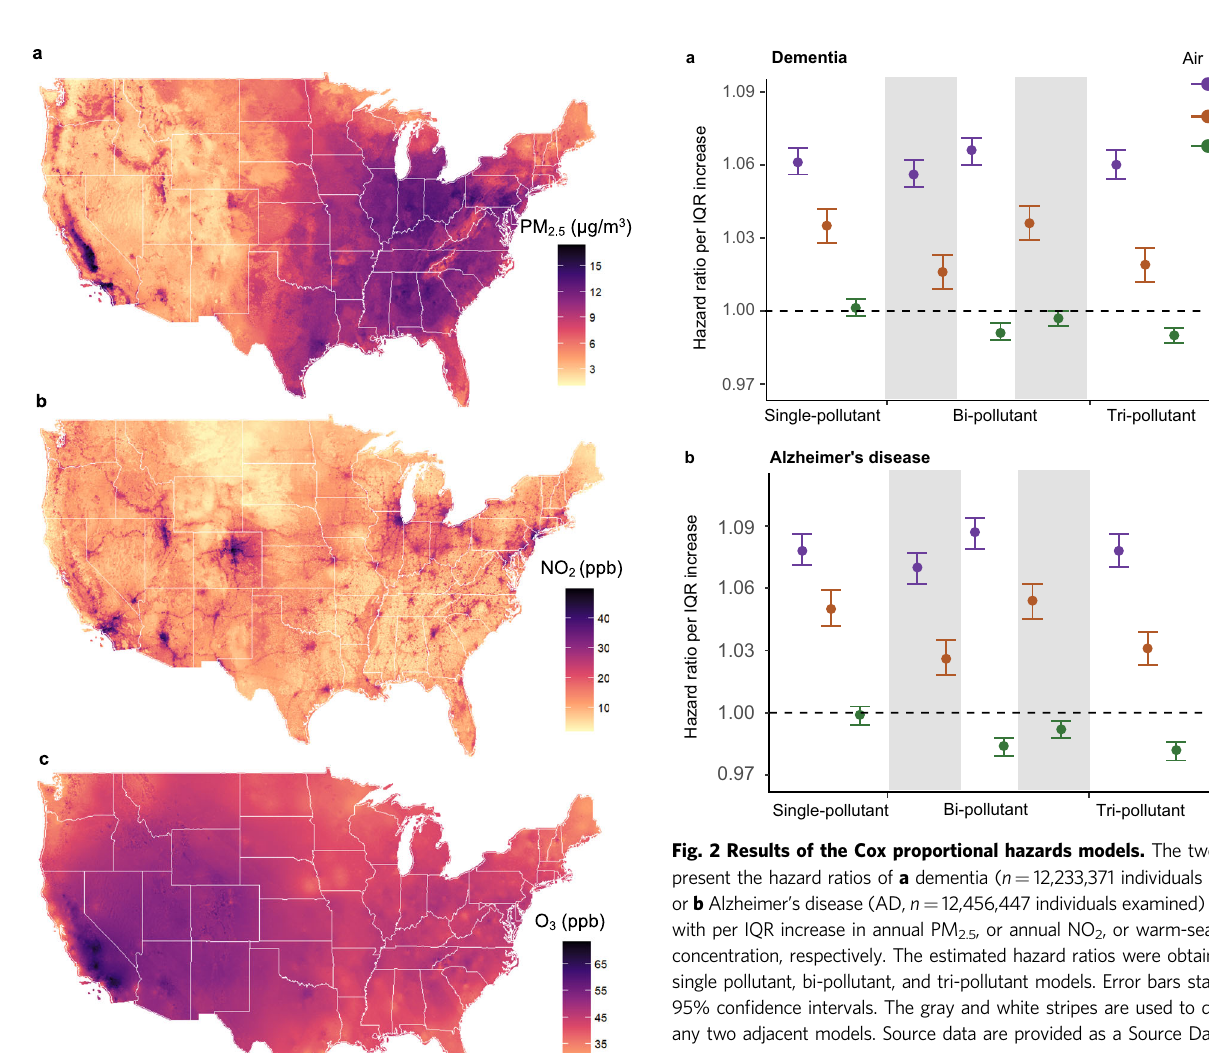
The fi ndings for AD have a similar pattern to those for dementia, but the hazard ratios (HRs) are higher per IQR increase, being 1.078 (95% CI: 1.071, 1.086) for PM 2.5 , 1.050 (95%